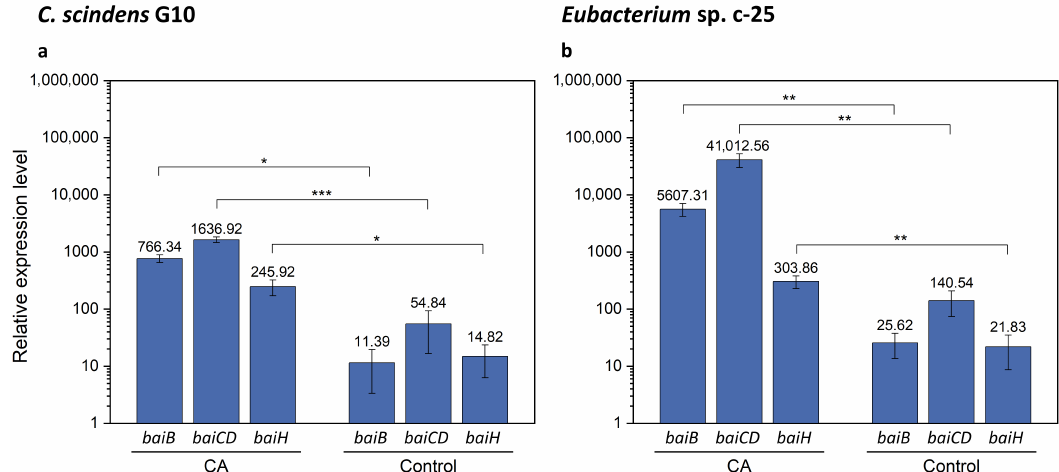
Figure 8. qRT-PCR results showing expression of baiB , baiCD , and baiH genes with or without CA supplementation. Expression was measured in ( a ) C. scindens G10 ( n = 3) and ( b ) Eubacterium sp. c-25 ( n = 7). Cells were cultured in GAM adjusted to pH 8 in the presence (CA) or absence (Control) of 0.1 mM CA and collected for total RNA extraction at mid-exponential growth phase. Mean values of the expression levels of each gene relative to the reference housekeeping gene recA are indicated. Error bars denote standard error of the mean. p -values lower than 0.05 were considered significant and indicated using numbers of asterisks in the panel (*: p < 0.05, **: p < 0.01, ***: p <